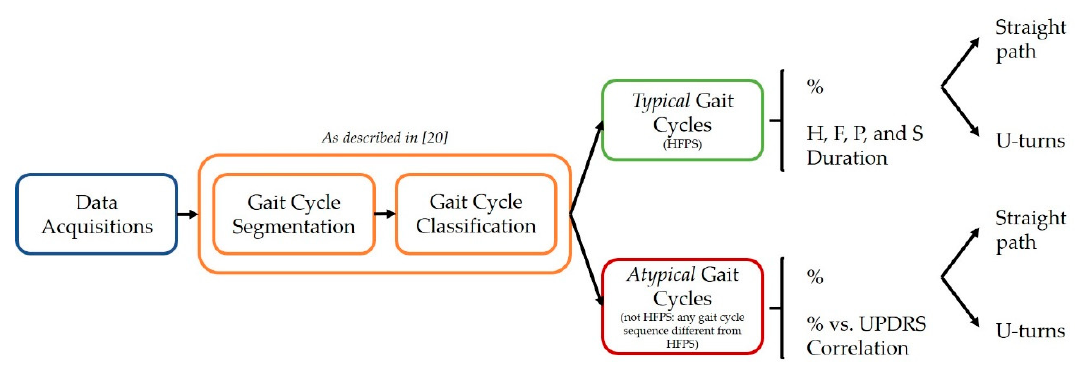
Figure 4. Schematic representation of the methodological steps implemented in this study from the data acquisition step to the assessment of the results.